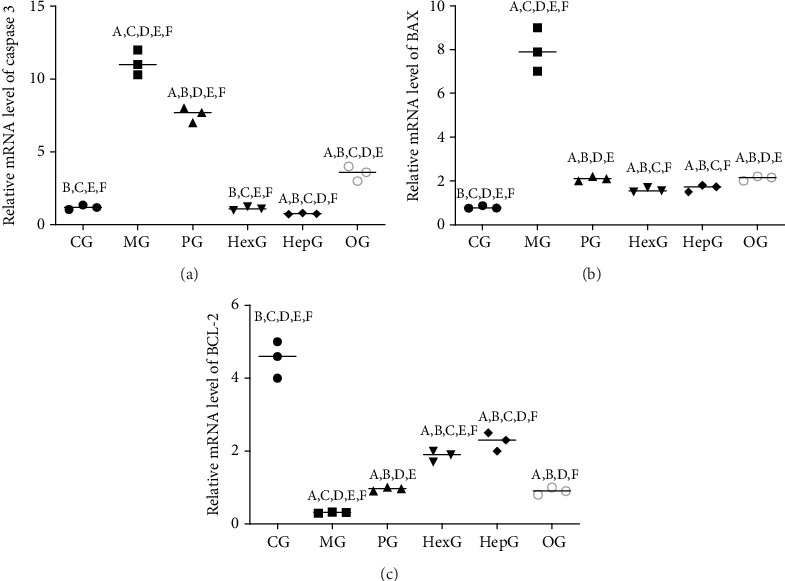
Real-time qPCR analysis of the relative mRNA levels of apoptotic factors. (a) Caspase 3. (b) BCL-2-associated X protein (BAX). (c) B cell lymphoma 2 (BCL-2). CG: control group; MG: model group; PG: chitopentaose-treated group; HexG: chitohexaose-treated group; HepG: chitoheptaose-treated group; OG: chitooctaose-treated group. n = 3 for each group. Ap < 0.05 vs. the CG group, Bp < 0.05 vs. the MG group, Cp < 0.05 vs. the PG group, Dp < 0.05 vs. the HexG group, Ep < 0.05 vs. the HepG group, and Fp < 0.05 vs. the OG group.